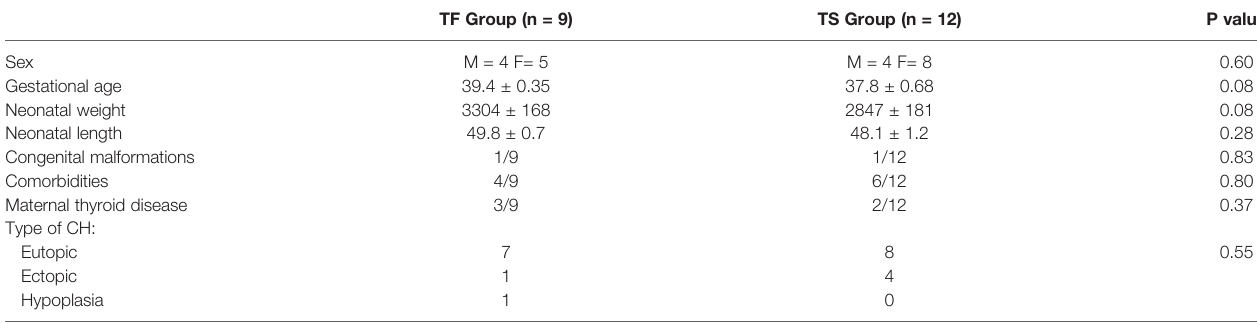
TF, Tifactor group; TS, Tirosint group.